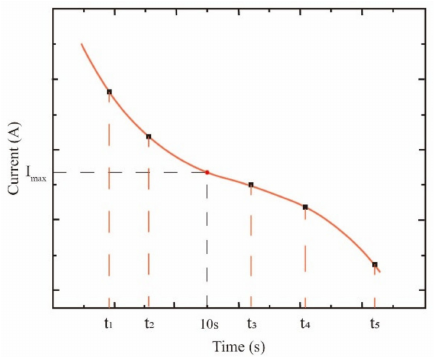
Figure 21. Nonlinear fitting between current and test time in the CC test-based